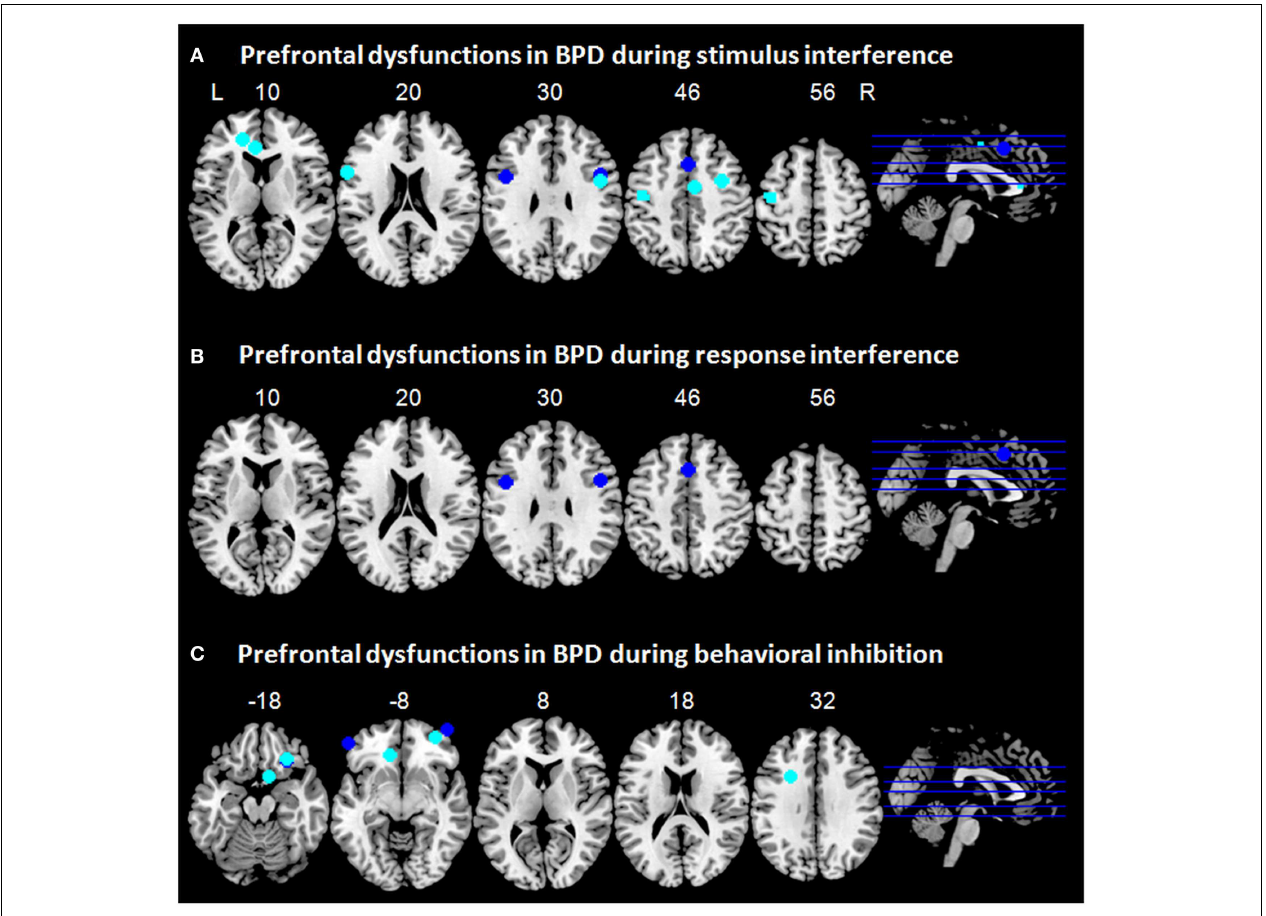
Silbersweig et al. (2007), andWingenfeld et al. (2009). Blue, prefrontal dysfunctions associated with emotionally neutral impulse control; cyan, prefrontal dysfunctions associated with emotionally modulated impulse control. L = left; R =